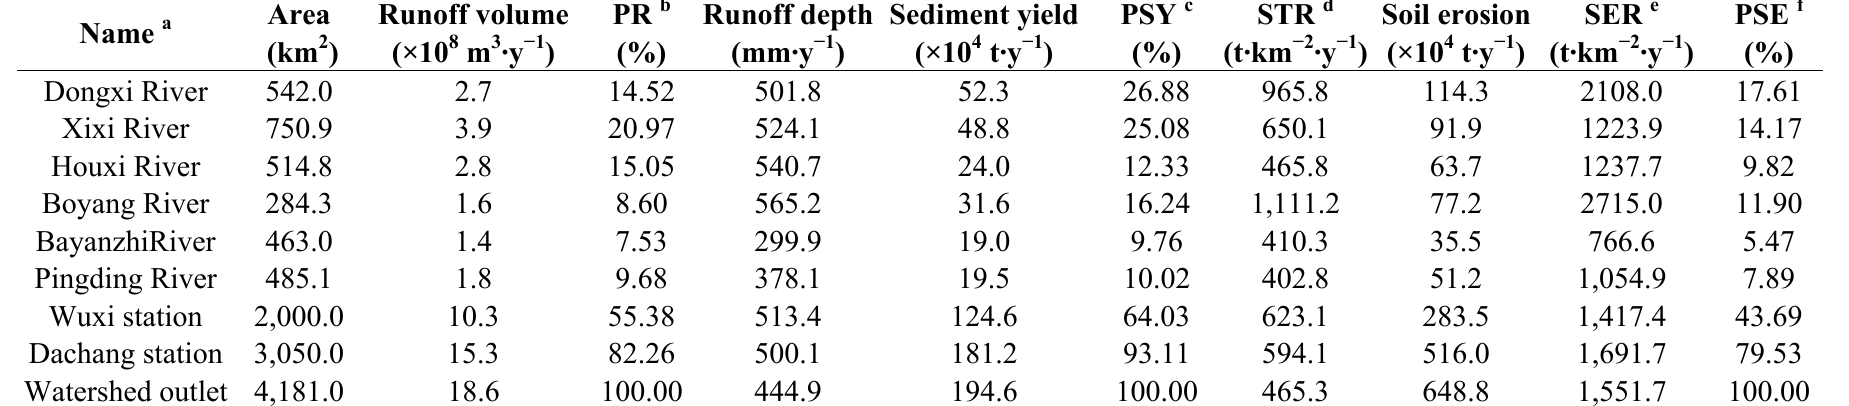
Table 4. Annual average runoff and sediment characteristics from main stem and six important tributaries predicted by AnnAGNPS in the Daning River